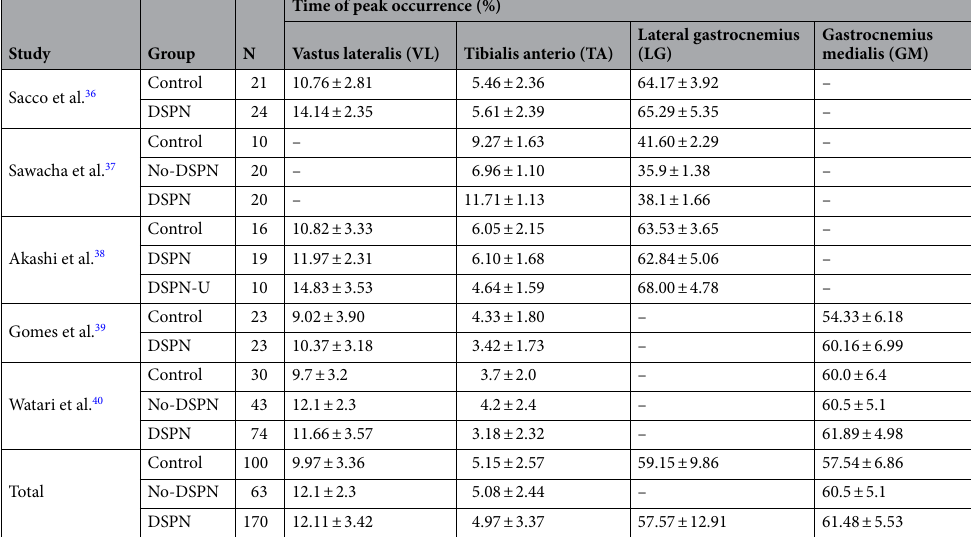
Table 5. Time of peak occurrence (%) in different lower limb muscle from EMG 36–40